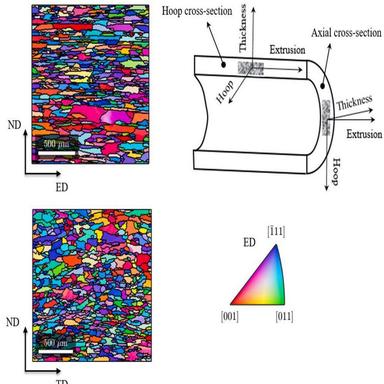
EBSD maps of a) the locations where EBSD imaging was performed on: b) Hoop cross-section and c) Axial cross-section.